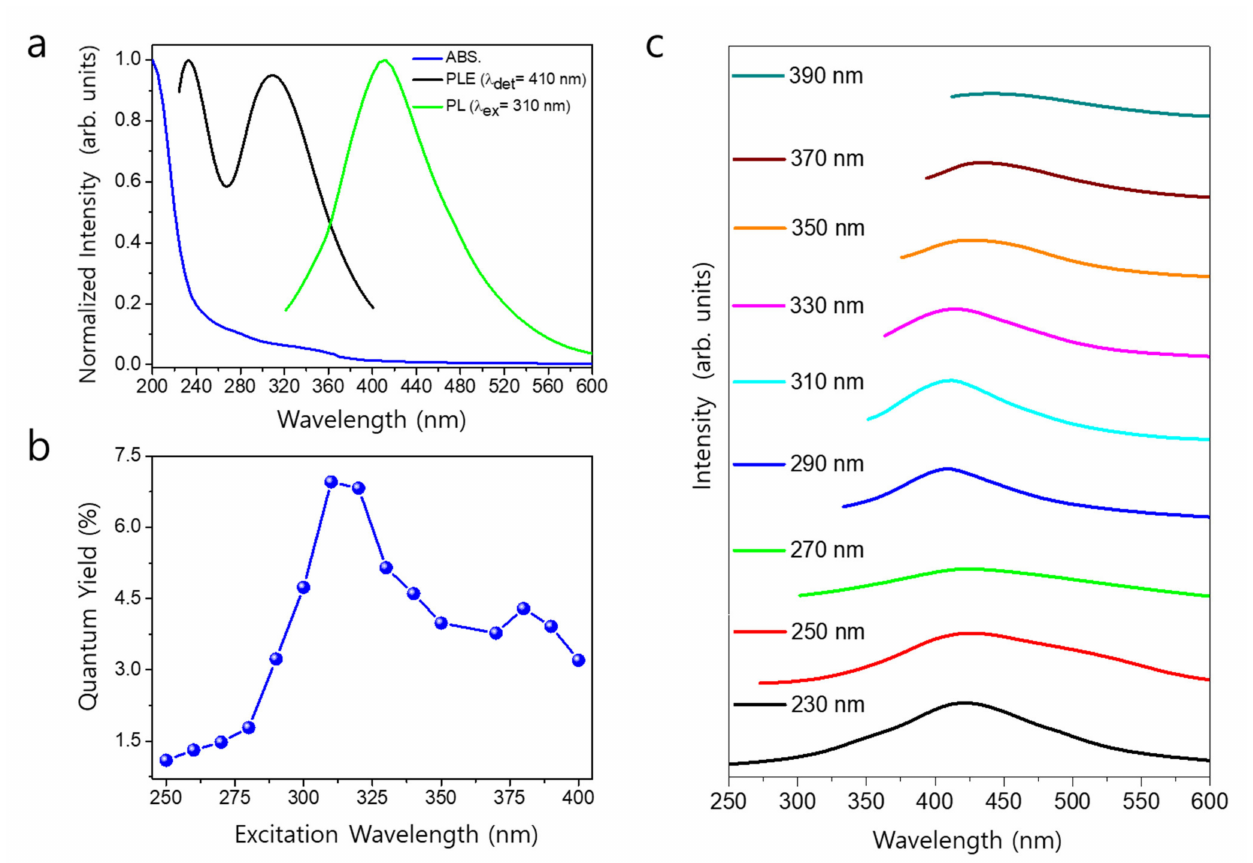
Figure 5. ( a ) UV-visible, PLE and PL spectra. Excitation wavelength dependent ( b ) PLQY and ( c ) PL spectra of the synthesized Ti 2 N